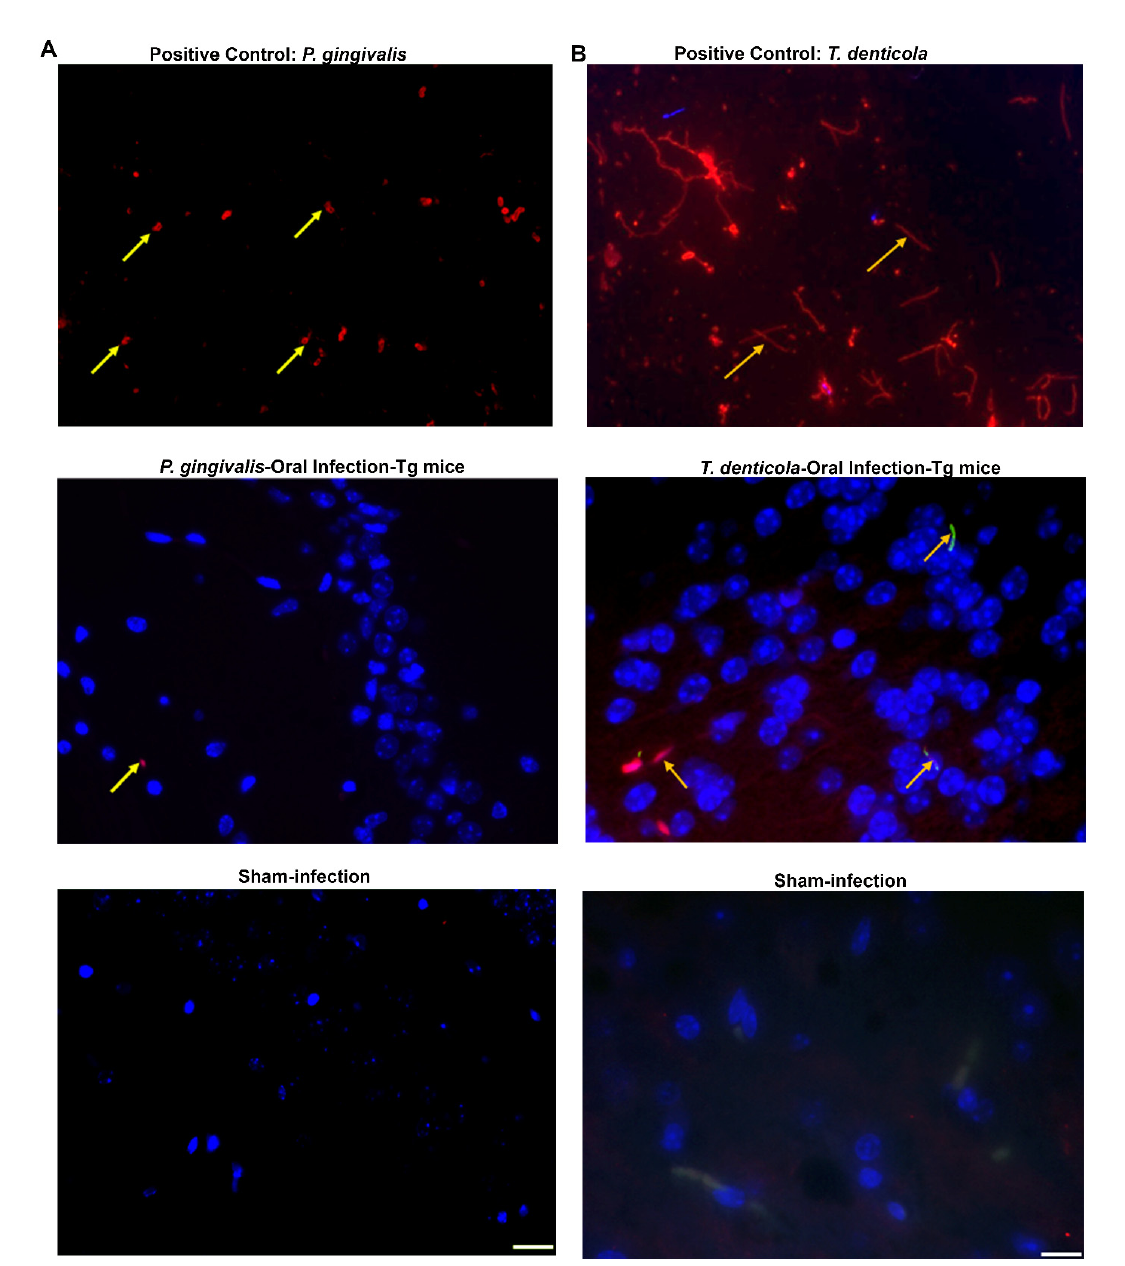
Figure 5. P. gingivalis gingival infection induced gingipain protease and dissemination of T. denticola in Tg mice brains. ( A ) Representative brain sections of the Tg and sham-infected mice were immunostained for P. gingivalis gingipain protease enzyme (important virulence factor). Live P. gingivalis was fixed with paraformaldehyde in a glass slide and used as a positive control (top panel). Gingipain protease was detected in the hippocampus of the mice following oral infection (middle panel). Gingipain protease was not detected in sham-infected mice brains (bottom panel). The yellow arrow in panel A denotes gingipain protease; Blue: DAPI stain. ( B ) Immunofluorescence microscopy analysis of T. denticola in mouse brain tissue. Positive control showing the structure of live T. denticola smeared on a glass slide and observed under a fluorescence microscope (1000 × ) (top panel). T. denticola like morphology (long, thin, slender, spiral-shaped) in the Tg mouse brain cortex (1000 × ) was observed (middle panel). T. denticola like morphology was not observed in sham-infected mice brains (bottom